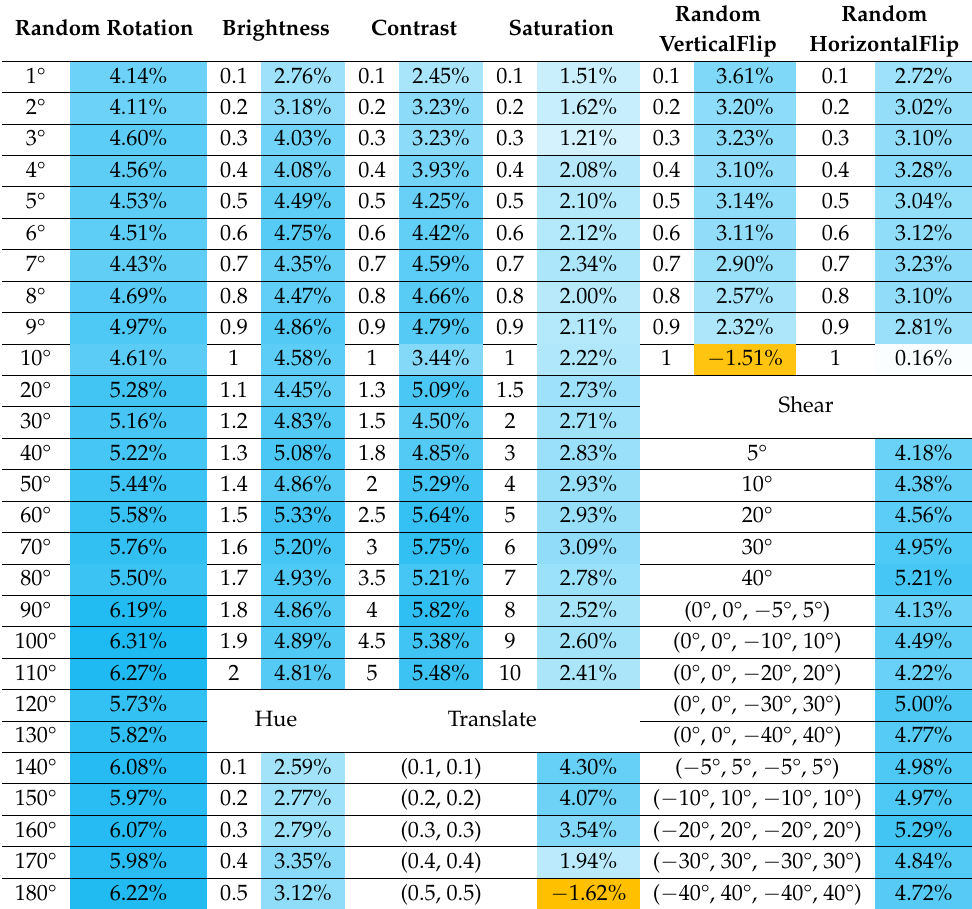
Table A4. Performance of DA methods on Γ train 50 with setting seed to 3500. The displayed percentage CCZ values describe the increase/decrease of mAA in percent. The value is color-coded from blue (increase in accuracy) over white (no effect) to orange (decrease in accuracy). This heatmap shows the effect of different DA methods and different parameters on the average accuracy improvement of Γ train 50 CCZ when setting seed to 3500. As with the experimental results on Γ train 50 , the performance of DA is PAP similar under different